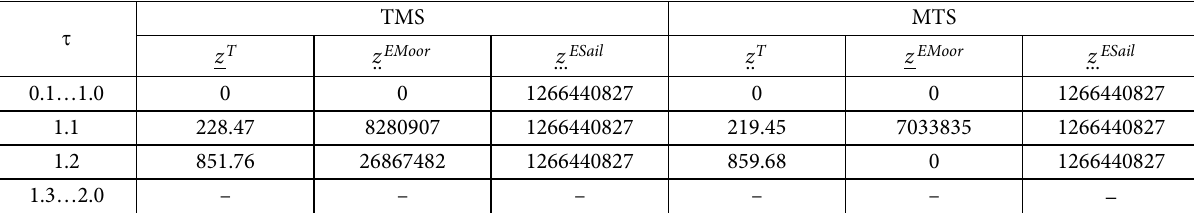
Table 5. The objectives affected by T i under the TMS and MTS strategies